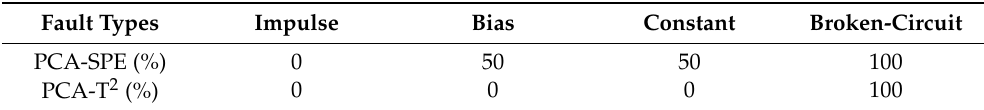
Table 5. Influence of outliers on fault detection.